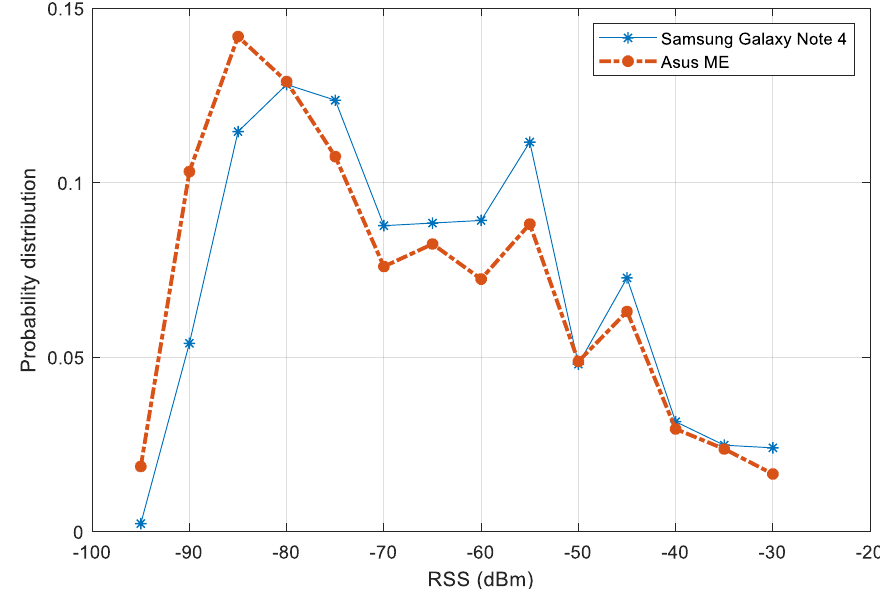
Figure 10. RSS value distribution of collected dataset for training fingerprinting model.